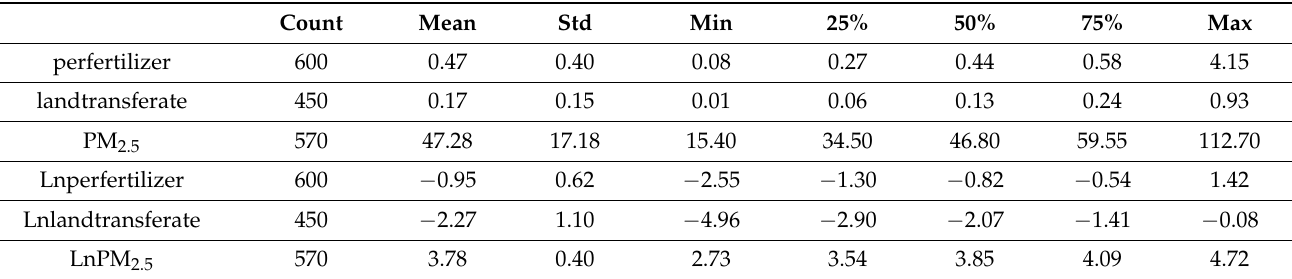
Table 1. Descriptive statistics of variables of interest.